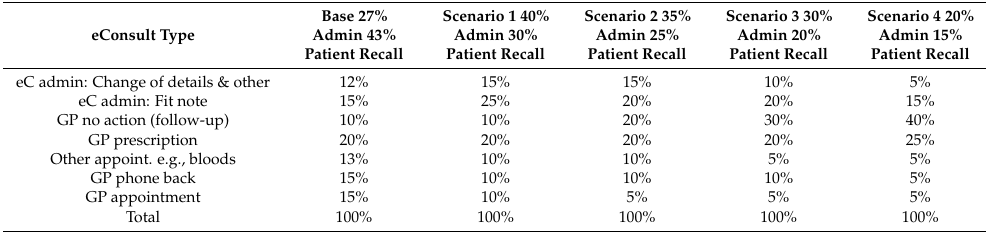
Table 5. Types of eConsult currently submitted and assumed in the 4 future scenarios (NB. Patient recall refers to eConsults that result in the patient returning to the surgery).